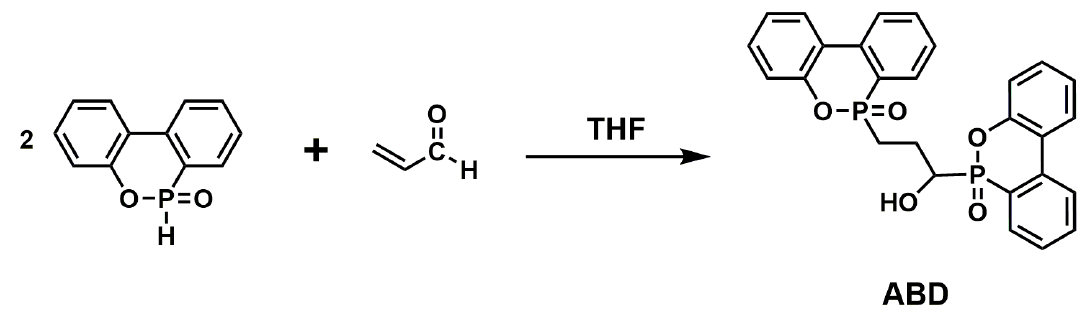
Figure 6. Synthesis route of ABD. Readapted with permission from Ref. [51], Copyright 2019, Elsevier Ltd.